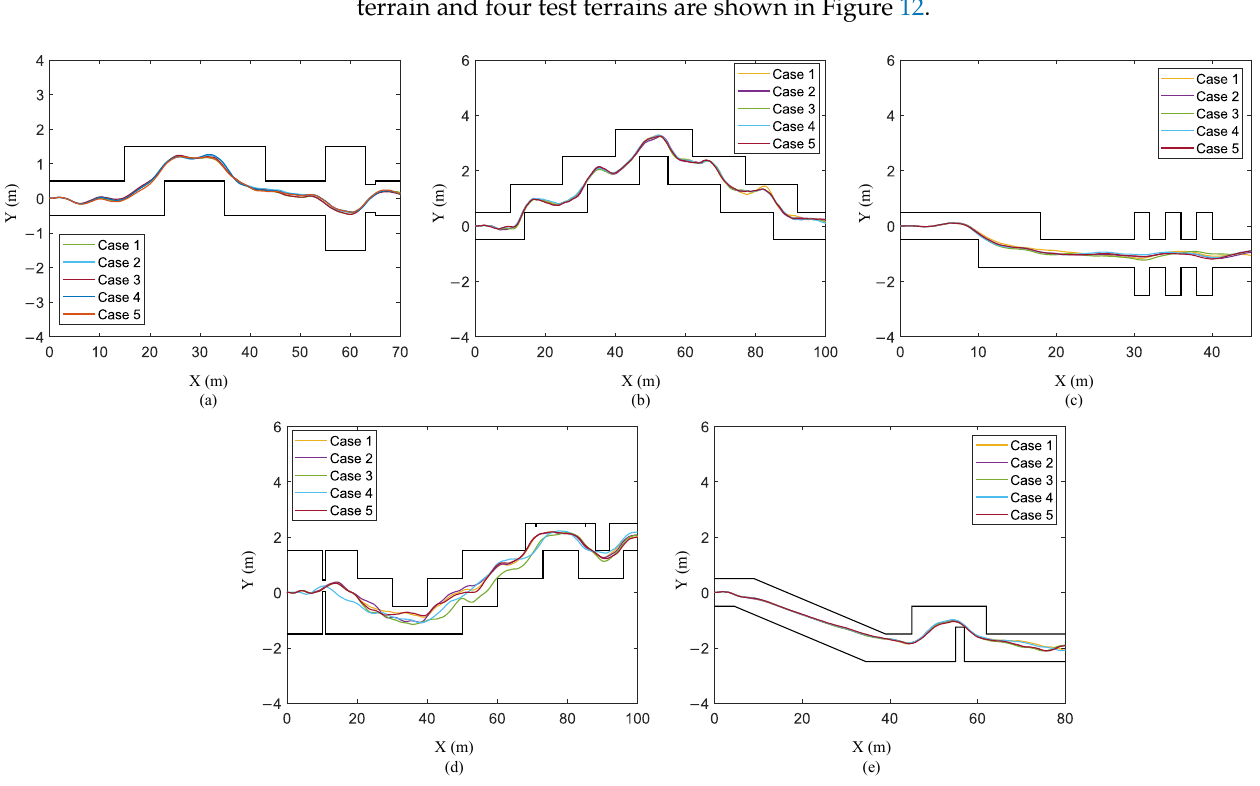
Figure 12. Trajectories of the STTW robot in test scenario I: ( a ) training terrain; ( b ) test terrain 1; ( c ) test terrain 2; ( d ) test terrain 3; ( e ) test terrain 4.